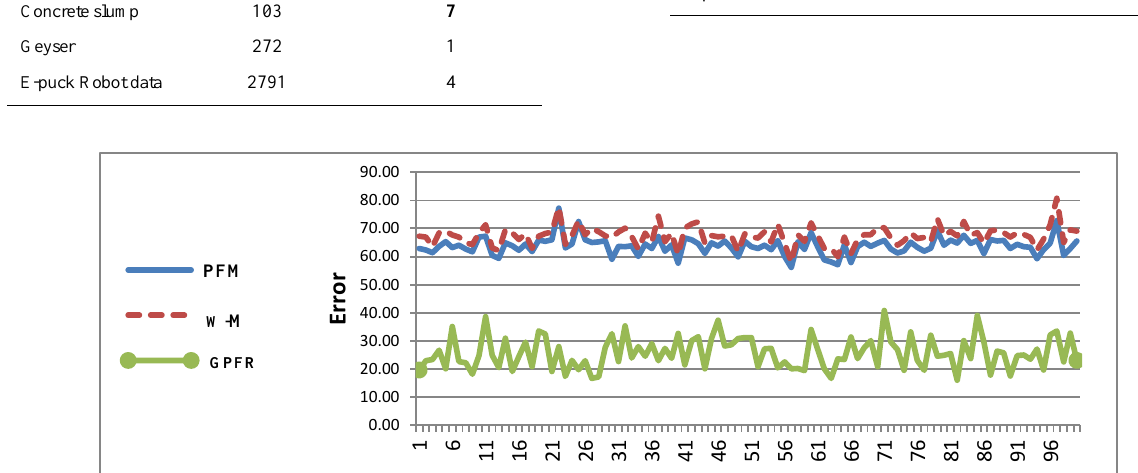
Figure 7. Error in Concrete